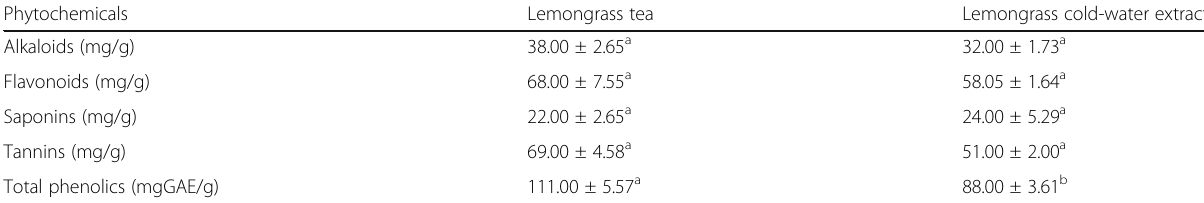
Table 1 Phytochemical contents of lemongrass tea and cold-water extract Phytochemicals